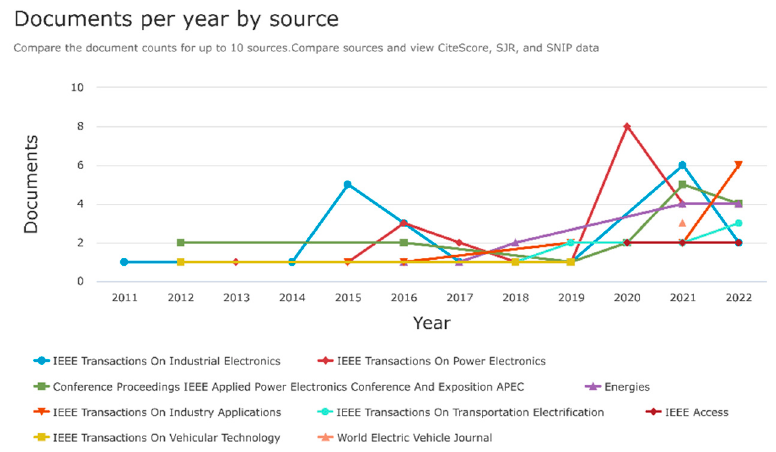
Figure 38. Publication per year by different publishers from 2020 to 2022.